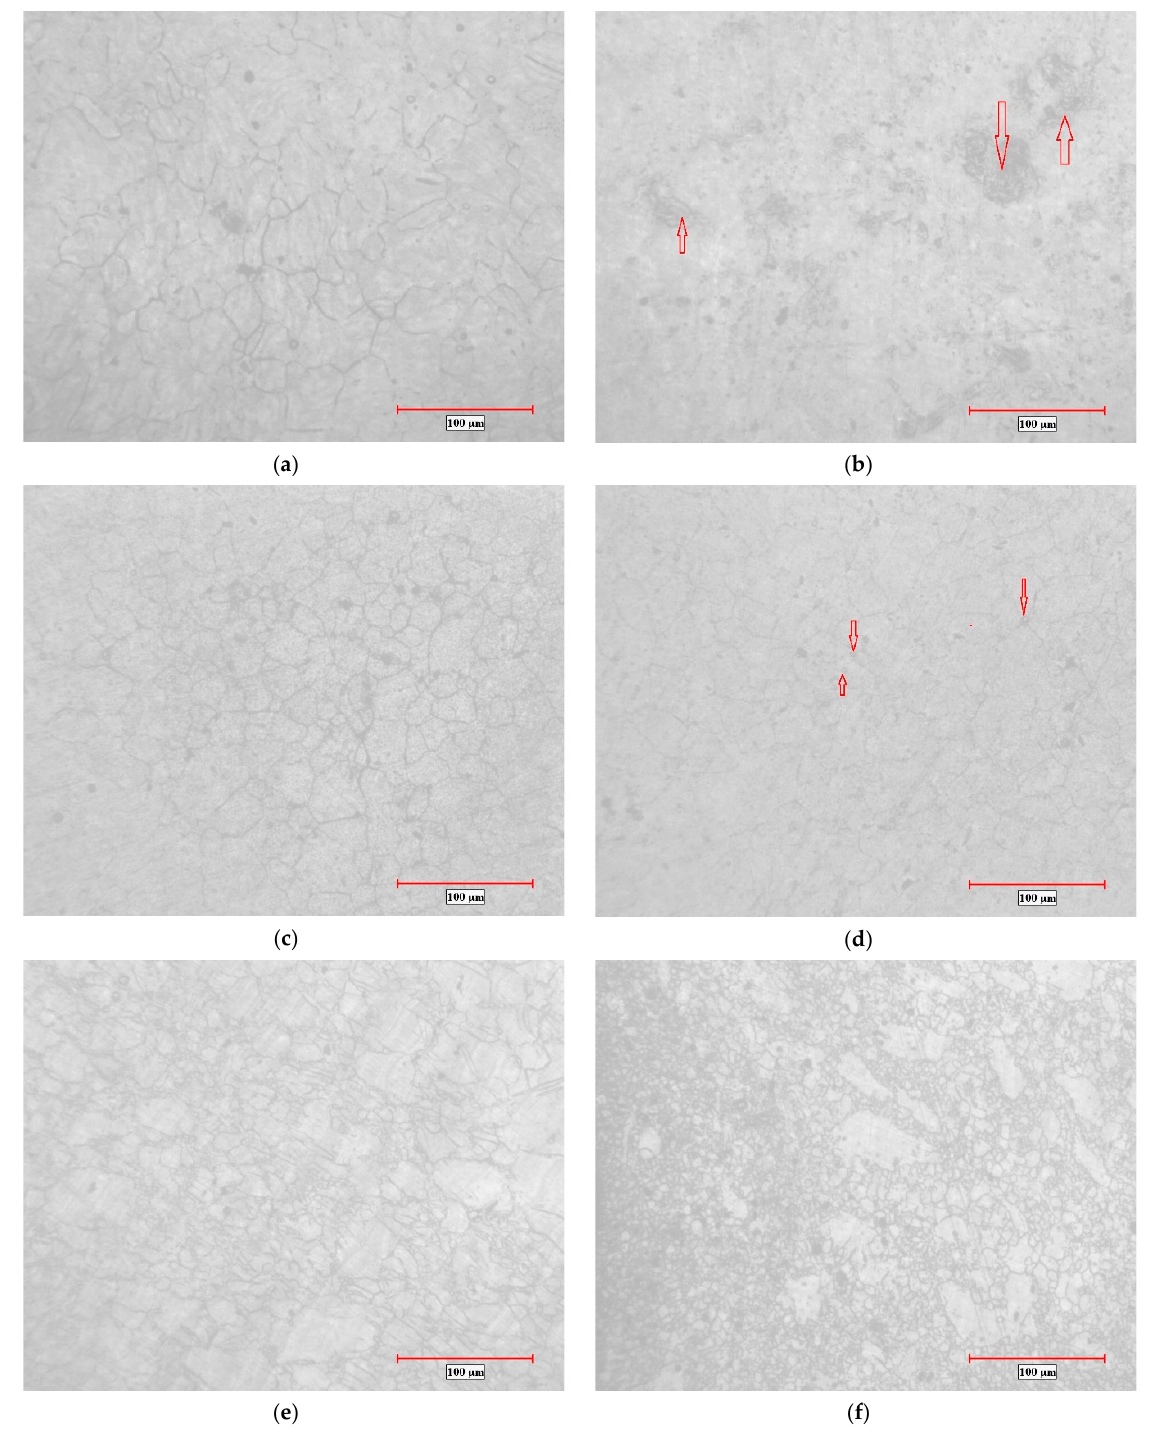
Figure 2. Optical microscopy (OM) micrographs of the AZ31 alloy after ECAP processing ( a , b ) as-annealed condition (AA), ( c ) ECAP processed through 1 pass (1-P), and ( e , f ) 2 passes of route Bc (2-Bc) (arrows indicate the secondary phase